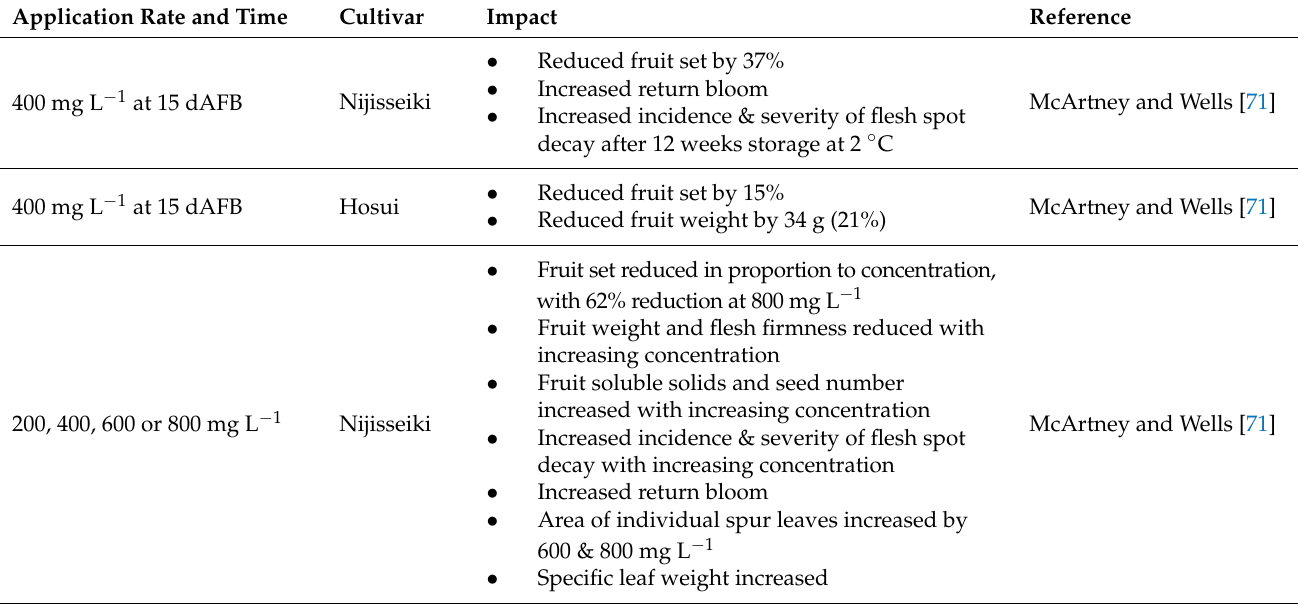
Table 8. Summary of the findings on the impact of ethephon as a chemical thinning agent for nashi. Application Rate and